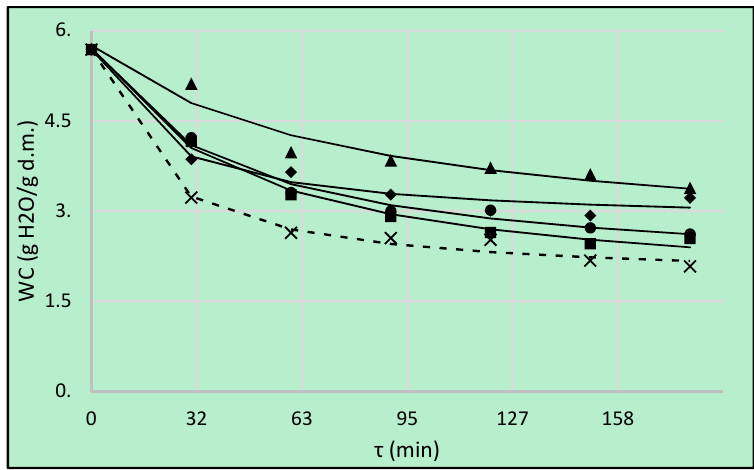
Figure 1. Water content ( WC ), kinetics using different solutions: erythritol ( ▪ ), xylitol ( ● ), maltitol ( ▲ ), dihydroxyacetone ( ♦ ), sucrose ( × ). Lines are the Peleg’s model. Dotted line is kinetic reference sucrose.